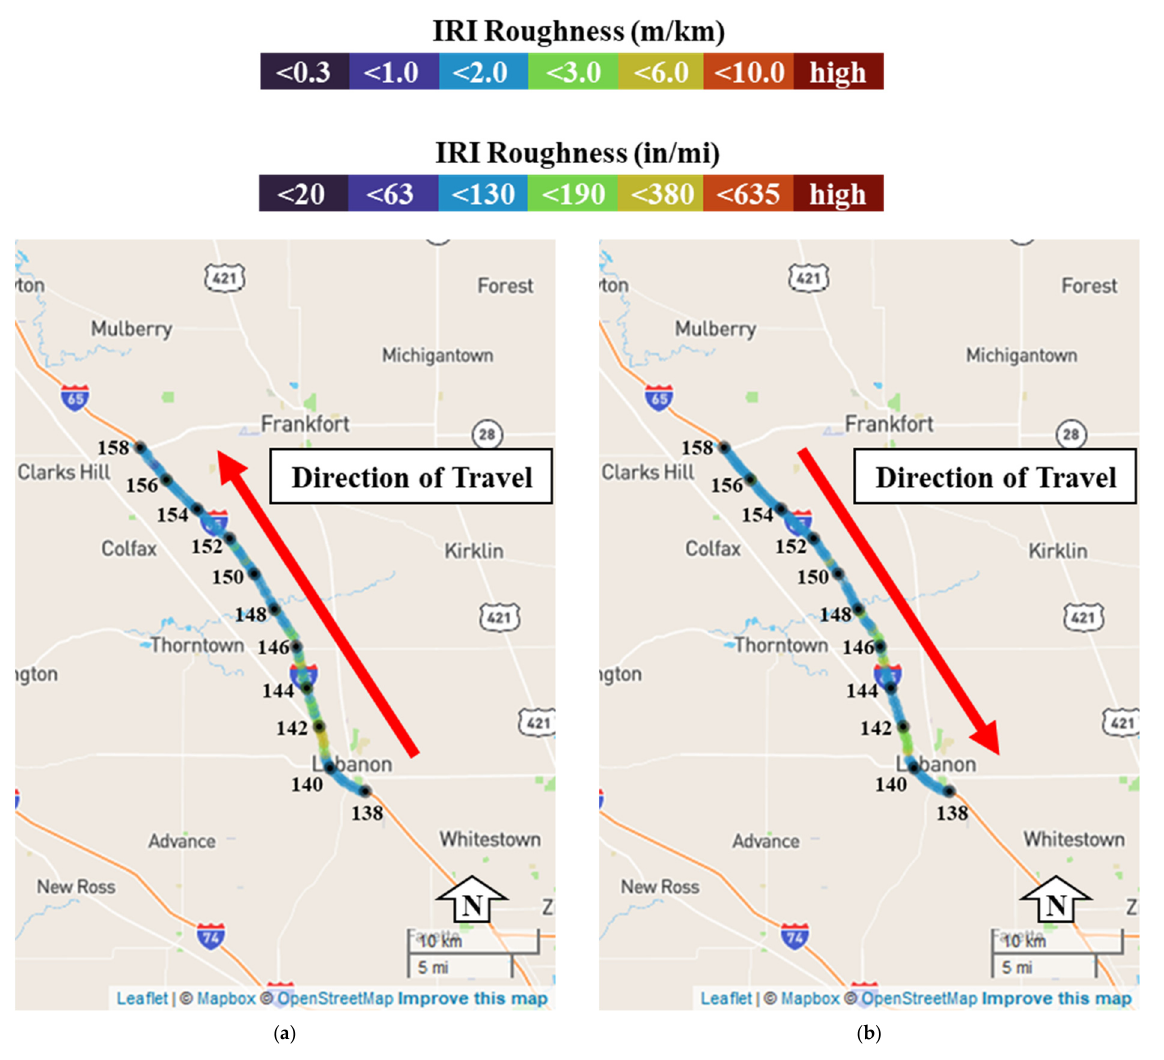
Figure 9. Spatial crowdsourced pavement roughness for I-65: ( a ) I-65 northbound; ( b ) I-65 south- bound.